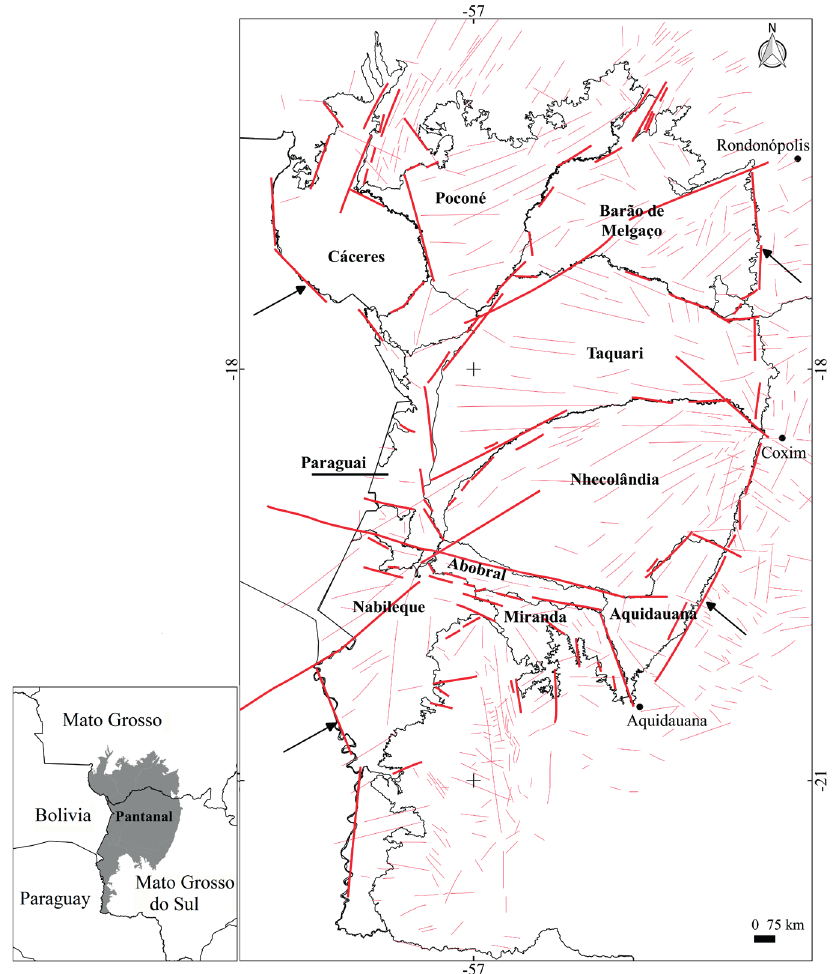
Figure 6 - Structural lineaments (in red) that coincide with the boundaries proposed by Silva and Abdon (1998) (in black). the arrows to the right indicate concordance between the lineaments and the Pantanal eastern border, characterized by the Maracajú ridge. the arrows to the left indicate lineaments coinciding with the Paraguay and Cáceres rivers, which are used as division lines between Brazil, Paraguay and